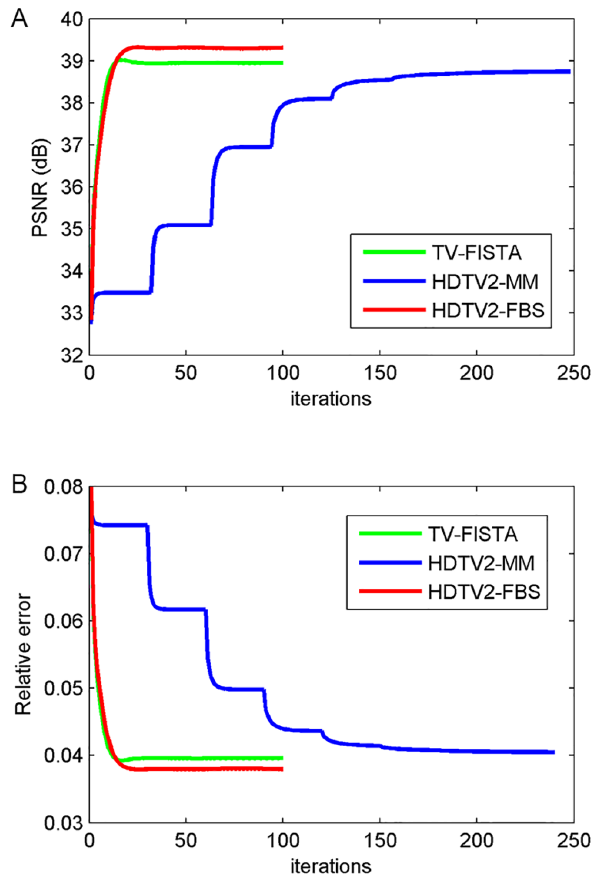
Fig 6. The convergence curve of PSNR and relative error results versus iterations corresponding to the reconstructed example shown in Fig 5. (A) PSNR versus iterations; (B) Relative error versus iterations.